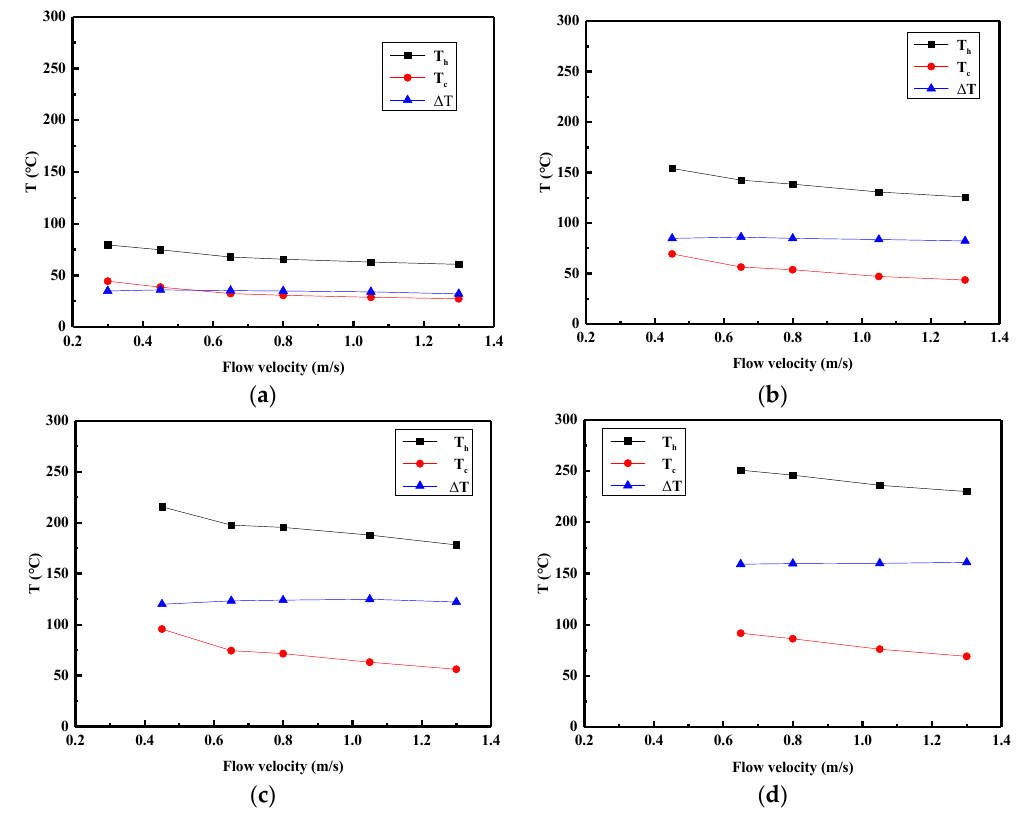
Figure 4. ( a ) 6000 W/m 2 , ( b ) 14,000 W/m 2 , ( c ) 22,000 W/m 2 , ( d ) 30,000 W/m 2 . Temperatures at various air flow velocity and heat flux with four thermoelectric modules. To further illustrate this, the temperature profile from the hot plate to ambient air is shown in Figure 5. The thermal resistance of the cold heat sink decreases with increasing ature difference for a given heat flux (from dashed line b to solid line a). Moreover, the temperature difference is significantly decreased owing to the reduction in the hot-side temperature and heat flux through the heat collector (from solid line a to dotted line c).